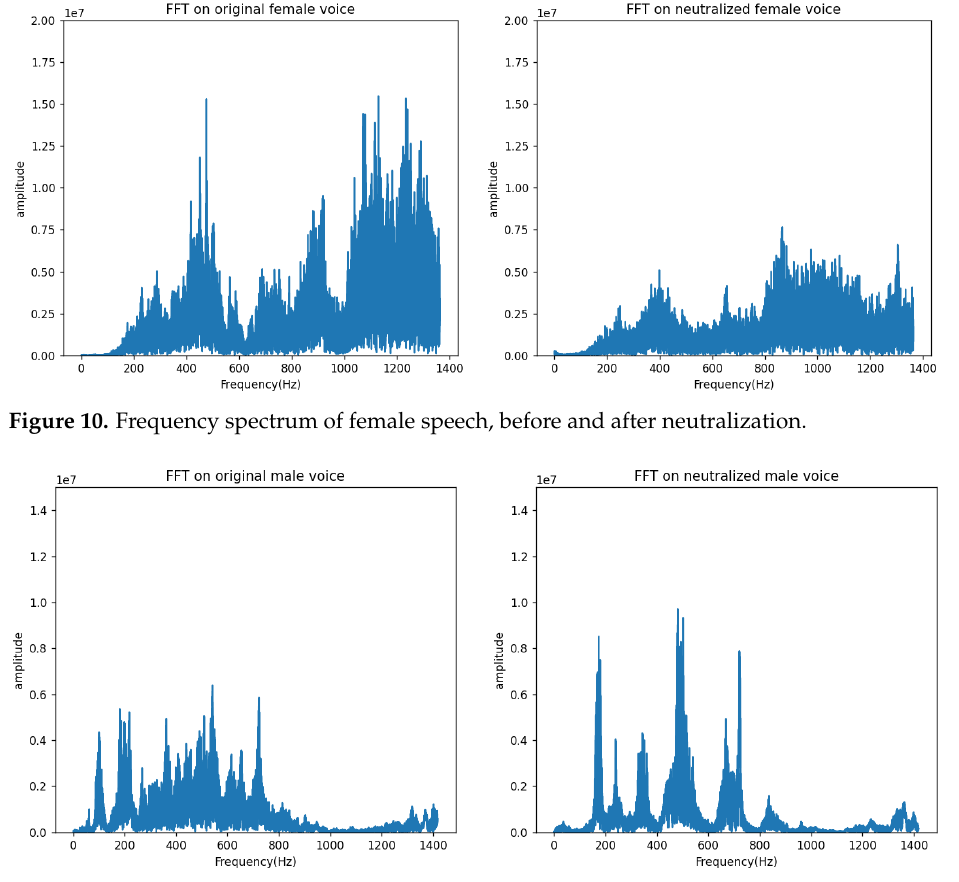
Figure 11. Frequency spectrum of male speech, before and after